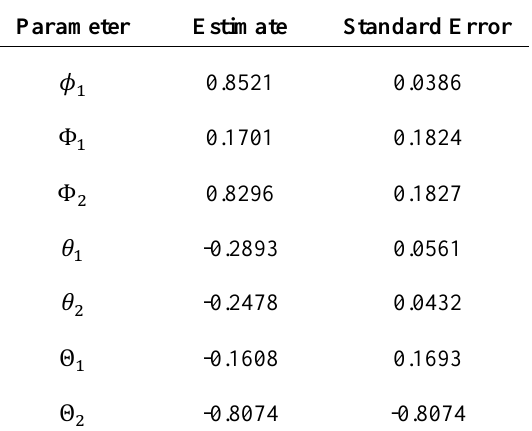
Table 2. Parameter